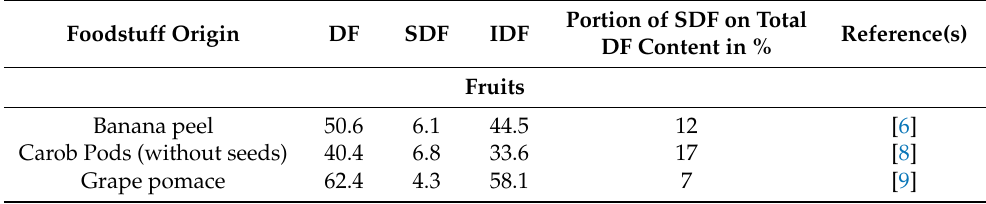
Table 1. Dietary fiber contents of by-product from processing of several fruits, crops and cereals (DF, SDF and IDF contents are given in g/100